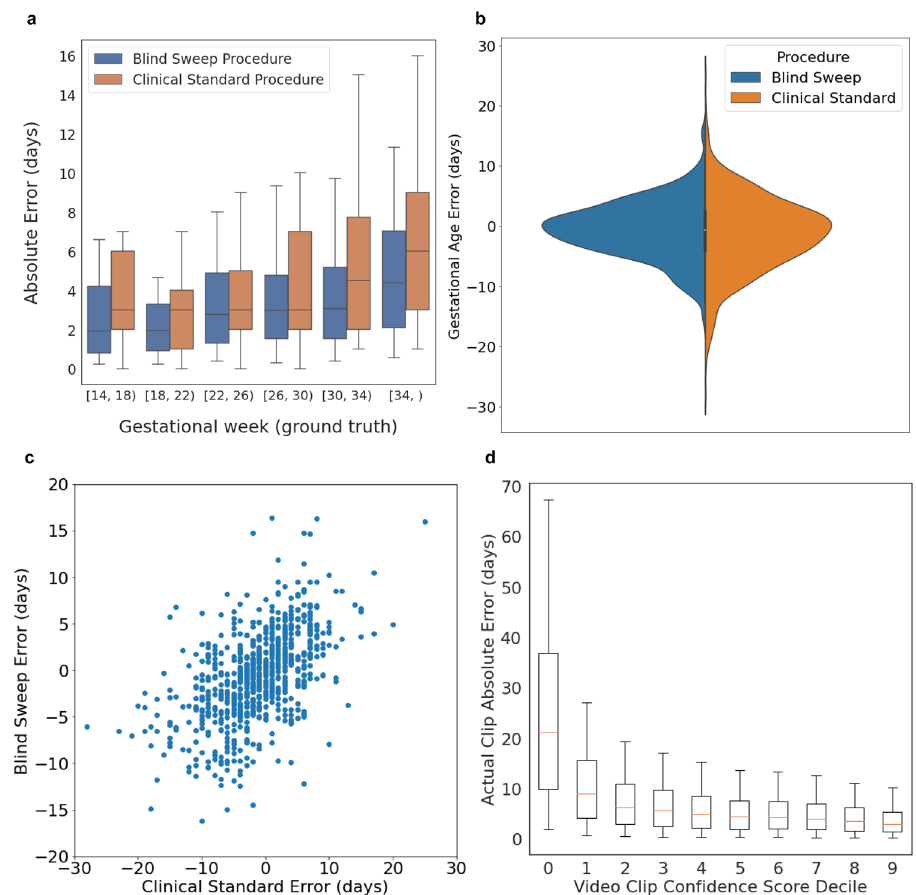
Fig. 2 Gestational age estimation. n = 407 study participants, blind sweeps performed by expert sonographers. a Blind-sweep procedure and standard fetal biometry procedure absolute error versus ground truth gestational age (4-week windows). Box indicates 25th, 50th, and 75th percentile absolute error, and whiskers indicate 5th and 95th percentile absolute error. b Error distributions for blind-sweep procedure and standard fetal biometry procedure. c Paired errors for a blind sweep and standard fetal biometry estimates in the same study visit. The errors of the two methods exhibit correlation, but the worst-case errors for the blind-sweep procedure have a lower magnitude than the standard fetal biometry method. d Video sequence feedback-score calibration on the test sets. The realized model estimation error on held-out video sequences decreases as the model ’ s feedback score increases. A thresholded feedback score may be used as a user feedback signal to redo low-quality blind sweeps. Box indicates 25th, 50th, and 75th percentile of absolute errors, and whiskers indicate the 5th and 95th percentile absolute